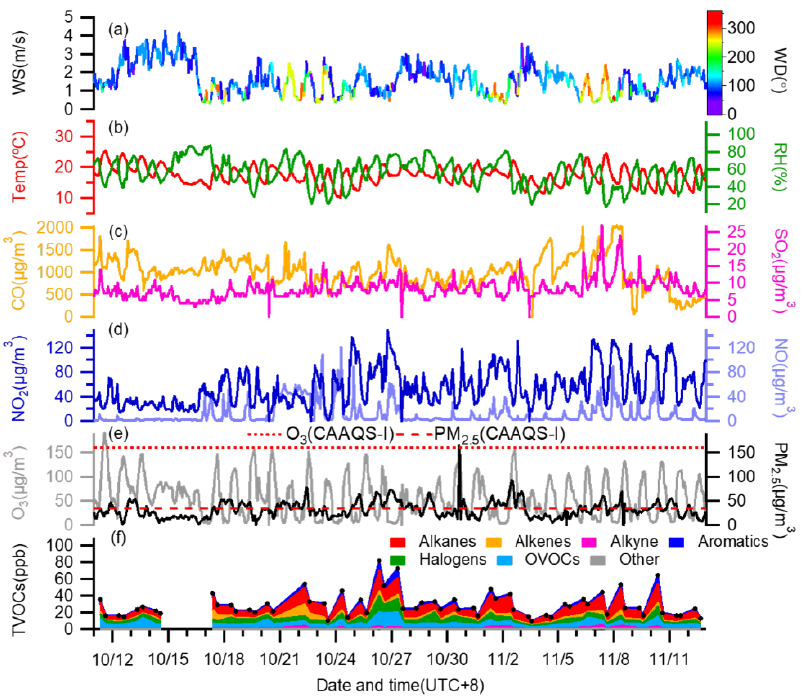
Figure 2. Time series of ( a ) wind speed (WS) colored by wind direction (WD), ( b ) relative humidity (RH) and temperature, concentrations of ( c ) CO, SO 2 , ( d ) NO 2 , NO, ( e ) O 3 , PM 2.5 , and ( f ) the total VOCs (TVOCs) during the whole campaign.